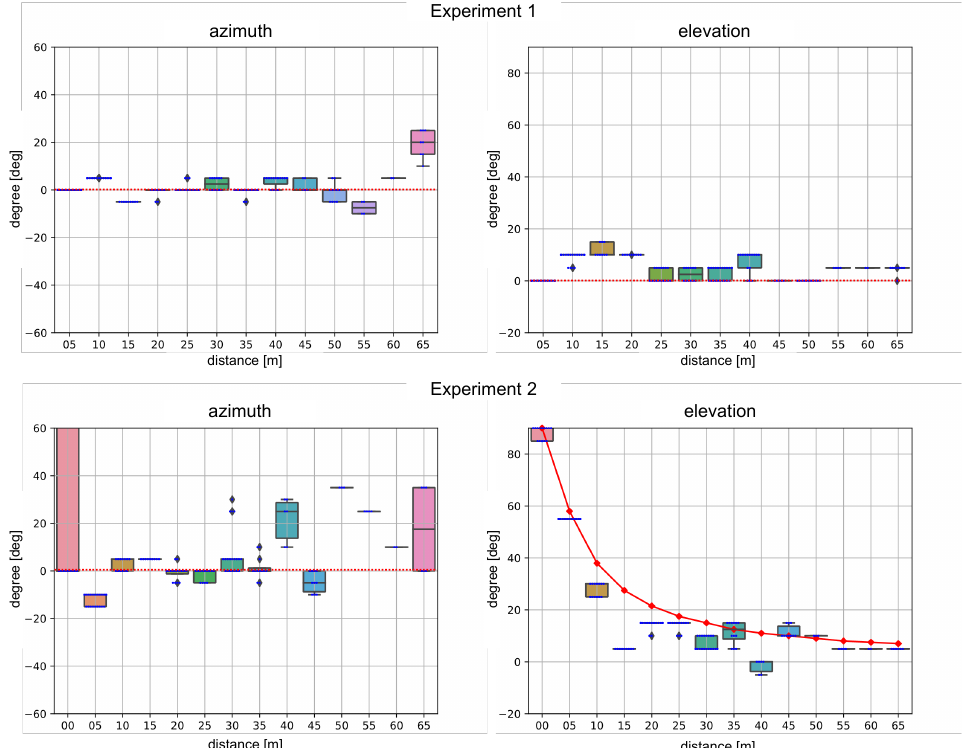
Figure 6. An estimated azimuth ( left ) and elevation ( right ) of replayed songs in Experiment 1 ( top ) and 2 ( bottom